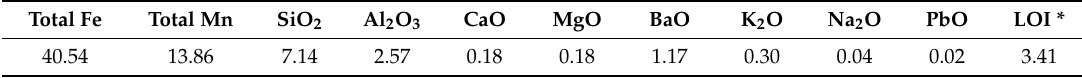
Figure 4. BSE (Back scattered electron) image ( a ) and elemental mapping ( b – f ) of the high-iron manganese ore. Table 1. Chemical composition of the manganese ore